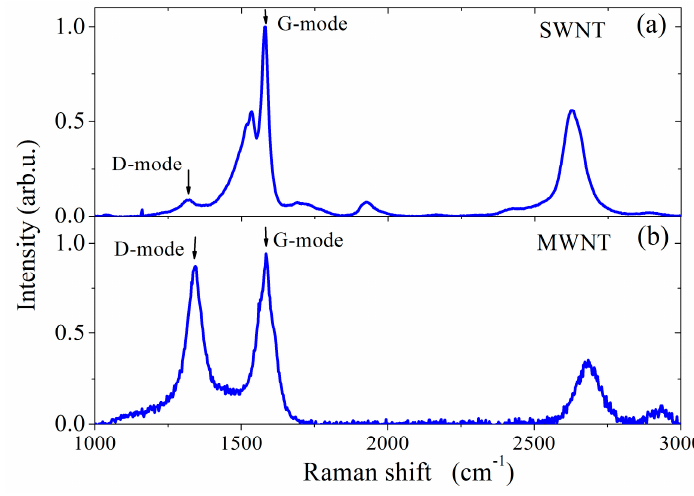
Figure 4. Raman spectra of ( a ) single-walled and ( b ) multiwalled CNTs.